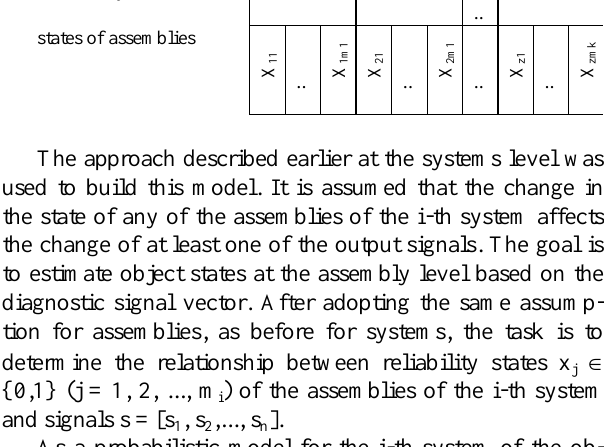
Table 1. Description of states at the level of engine systems and assemblies states of